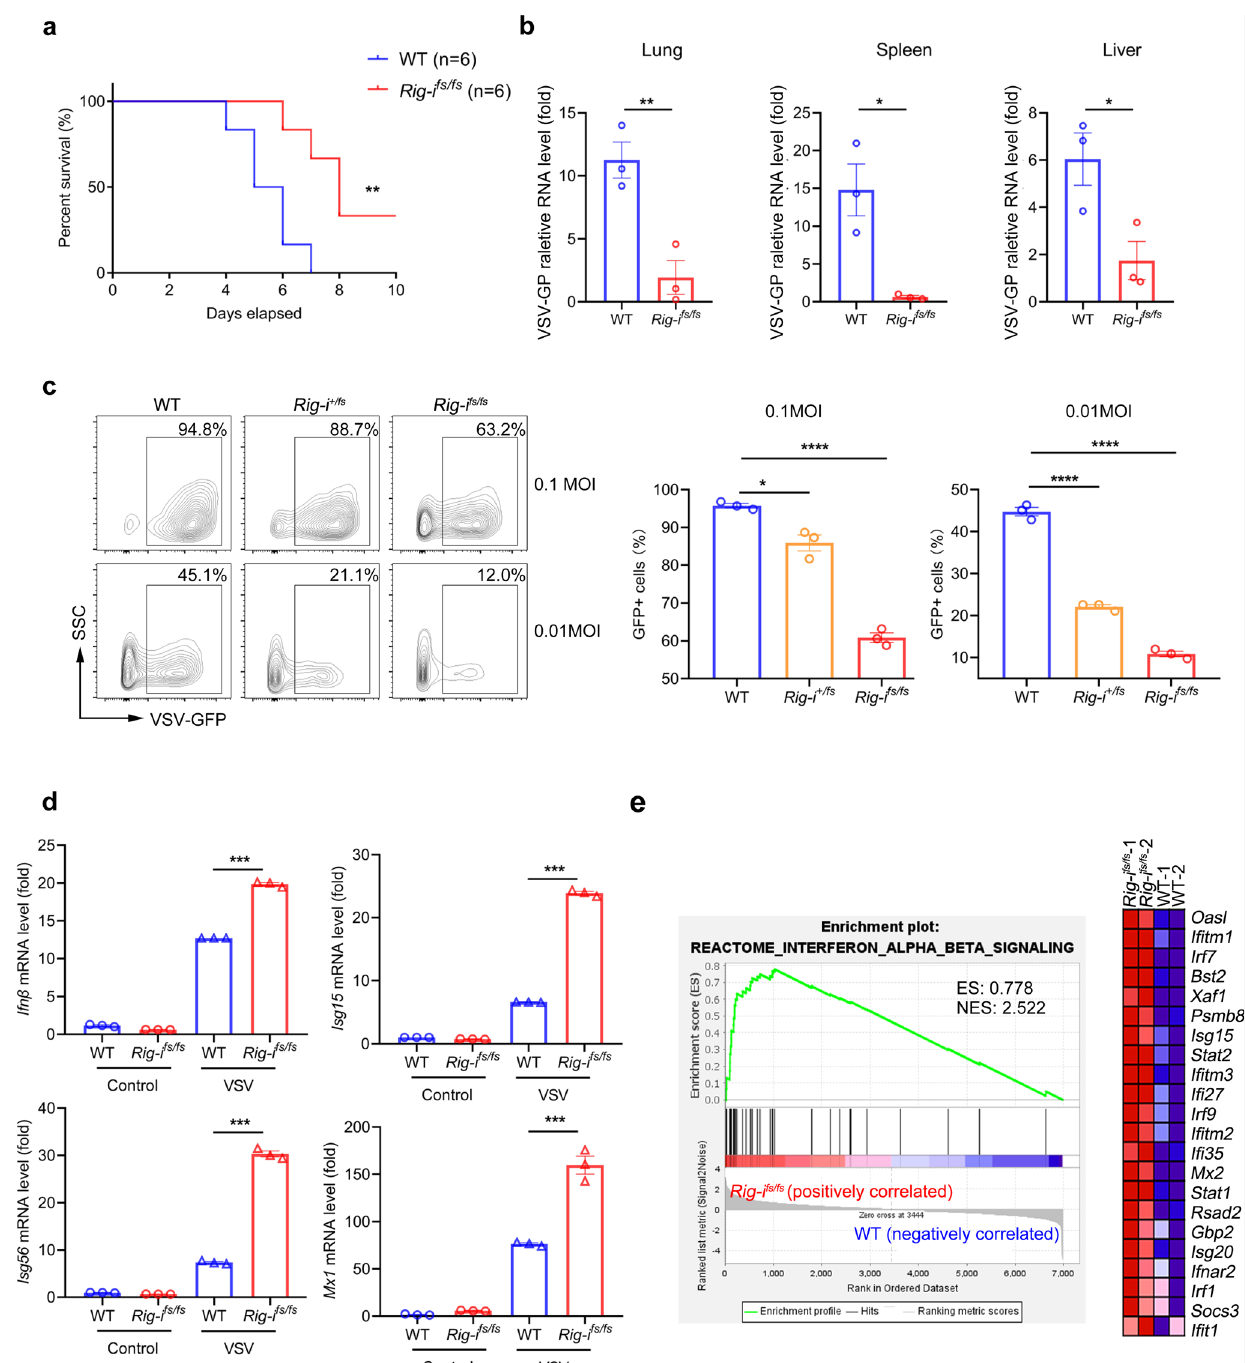
VSV ( n =6 mice, ** P =0.0062, log-rank (Mantel – Cox) test). b RT-qPCR analysis